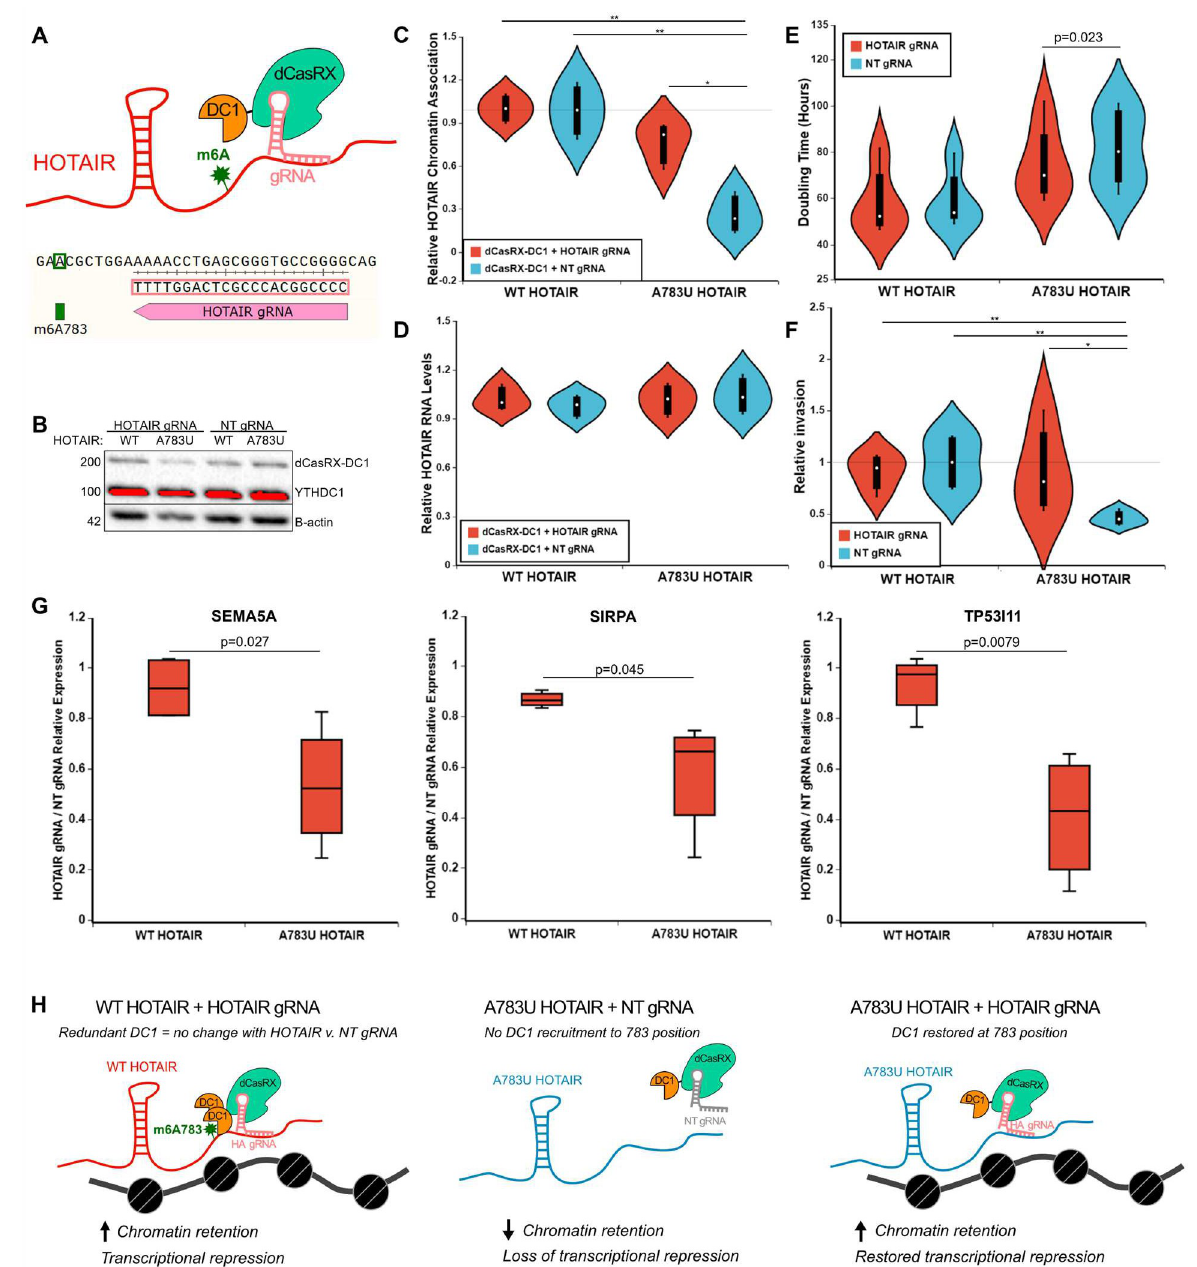
Fig 6. Tethering YTHDC1 to A783U mutant HOTAIR restores chromatin localization independent of changes in RNA levels. (A) Schematic of tethering strategy using a dCasRX-YTHDC1 fusion protein and a guide RNA targeted just downstream of A783 in HOTAIR. (B) Western blots for YTHDC1 (upper) and B-actin (lower) on dCasRX-YTHDC1 transfected cells, as noted. (C) Similar analysis described in Fig 3D and 3E was performed on fractionated RNA samples from cell lines overexpressing WT or A783U HOTAIR transfected with a plasmid containing dCasRX-YTHDC1 in combination with a HOTAIR or NT gRNA, as noted. Three biological replicates were performed. (D) Relative HOTAIR RNA levels in Input samples from C. Three biological replicates were performed. (E) Doubling time of samples described in C. Four biological replicates were performed. (F) Relative Matrigel invasion of samples described in C was determined. Six biological replicates were performed. Samples that did not show higher invasion in WT HOTAIR + NT gRNA vs. A783U HOTAIR + NT gRNA were excluded from the analysis. Invasion was normalized to WT HOTAIR + NT gRNA samples. Final analysis represents 4 biological replicates. (G) Relative expression of HOTAIR gRNA samples compared to NT gRNA samples for WT HOTAIR-down-regulated genes noted. (H) Schematic for observed effects of tethering YTHDC1 to HOTAIR using dCasRX. Numerical values in panels 6C–G are included in S2 Data. NT, non-targeting; WT, wild-type.